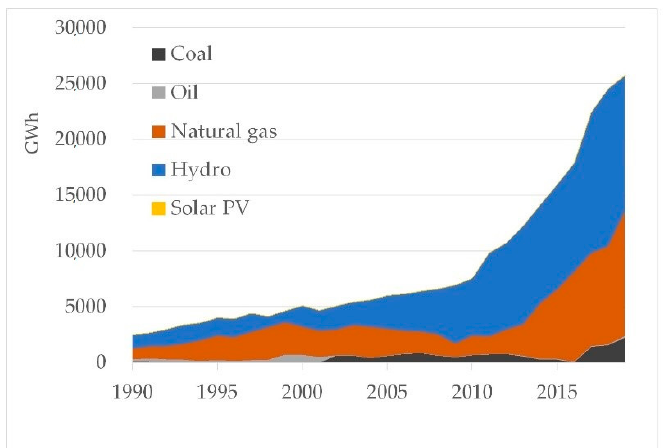
Figure 1. Electricity generation by sources. Reproduced by the authors based on the data from the International Energy Agency (IEA)